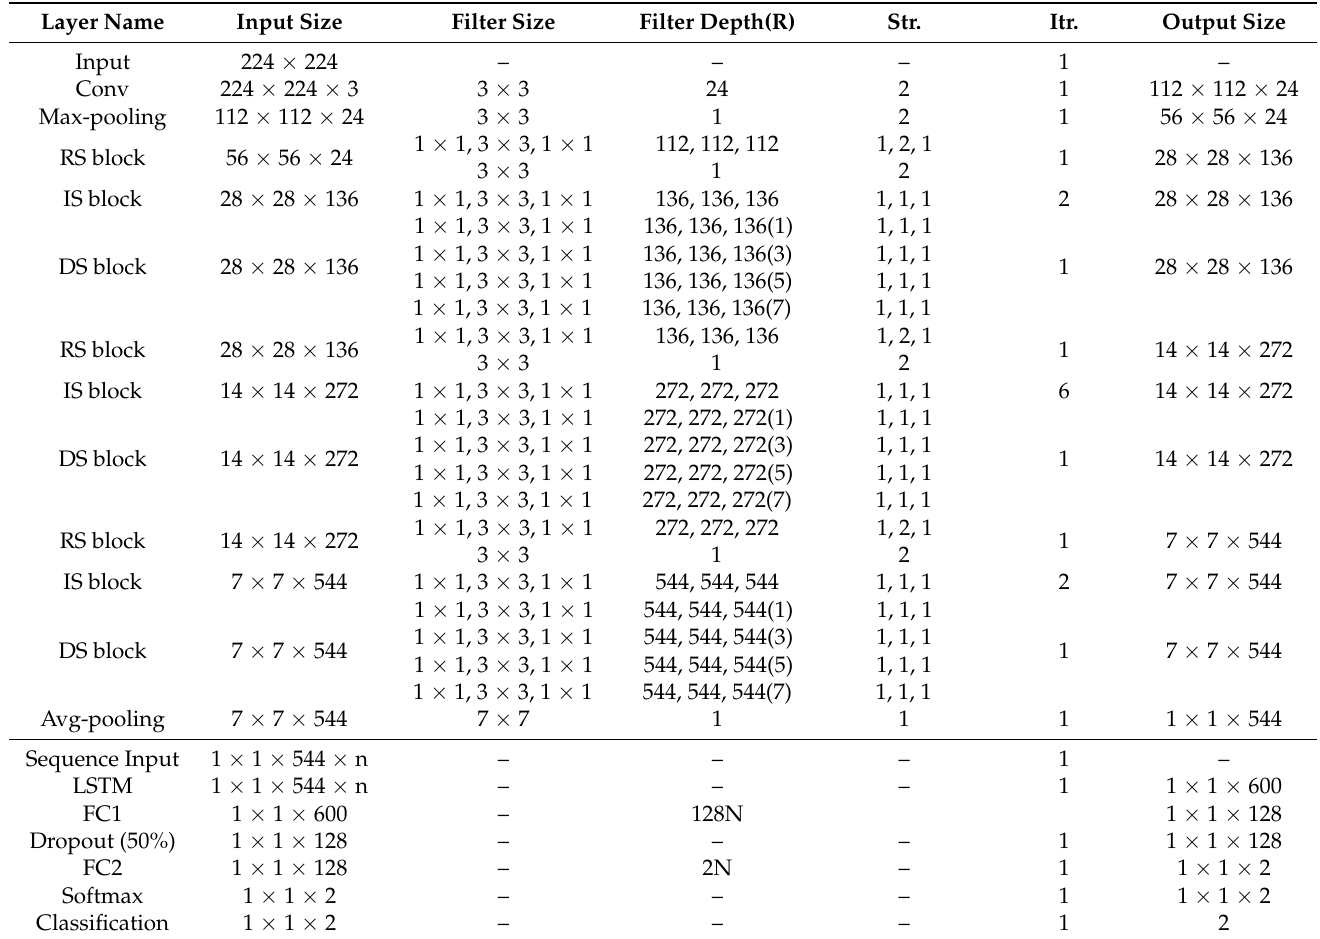
Table 1. Layer-wise configuration details of the proposed dilated shuffle sequential network (DSS-Net) (“Conv: Convolutional layer”, “N: Number of nodes in FC layer”, “R: Dilation rate”, “Itr.: Num- ber of